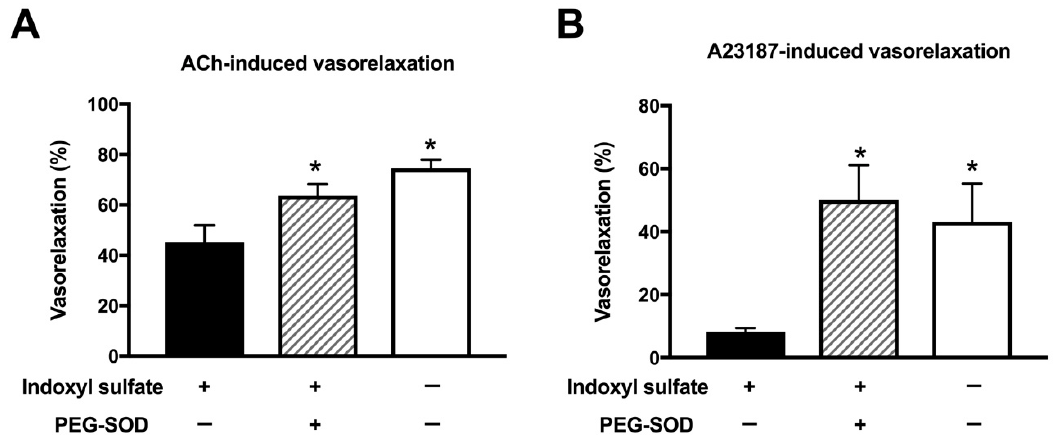
Figure 6. Effect of cell-permeant SOD on vasorelaxations induced by 3 × 10 − 7 mol/L acetylcholine (ACh) ( A ) or 10 − 7 mol/L A23187 ( B ) in the aorta treated with or without indoxyl sulfate. Polyethylene glycol-conjugated superoxide dismutase (PEG-SOD) (41 U/mL) was applied for 15 min; thereafter, indoxyl sulfate (10 − 4 mol/L) was incubated for 30 min before phenylephrine (PE) application. The ordinate shows vasorelaxation as a percentage of PE-induced vasocontraction (0% being defined as the plateau level of precontraction). Data are presented as mean ± standard error of mean (SEM) values from six experiments. * p < 0.05 vs. indoxyl sulfate group.